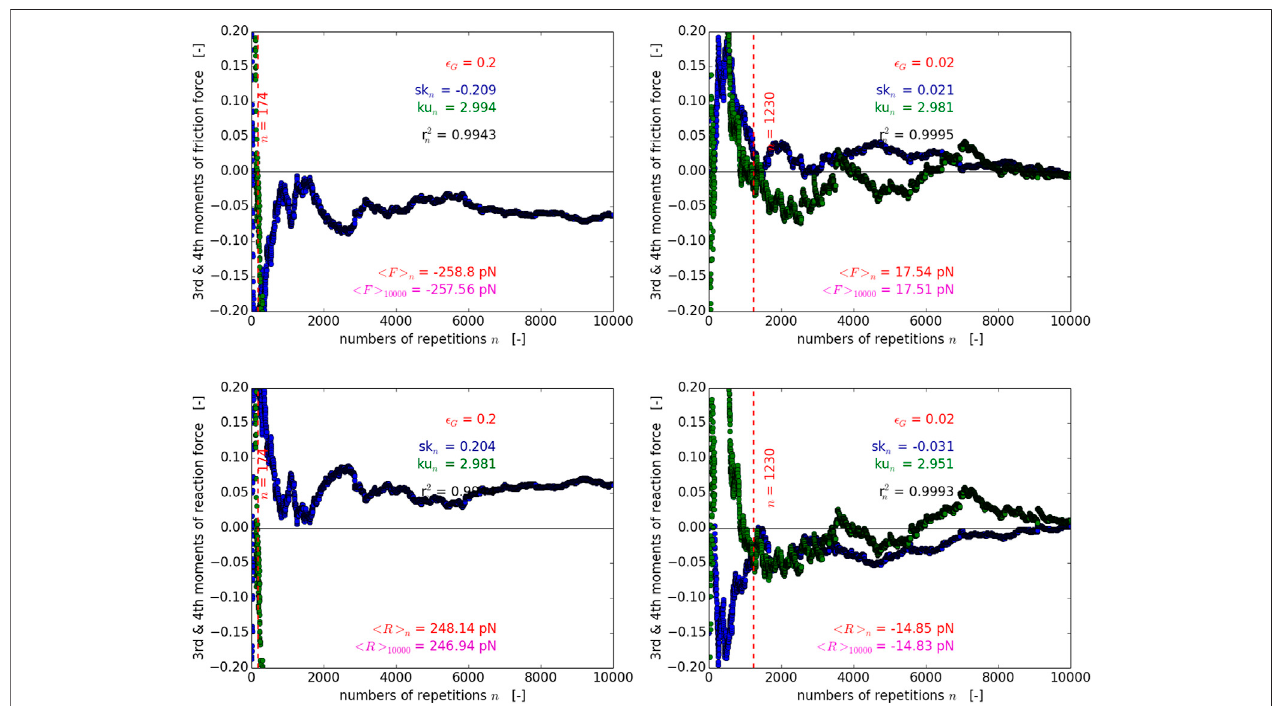
FIGURE 6 | As in Figure 5 , for the friction (top row) and reaction force (bottom row) within a stick-slip (left panels) and a superlubric frictional regime (right panels) obtained by applying the 2D PT-model.